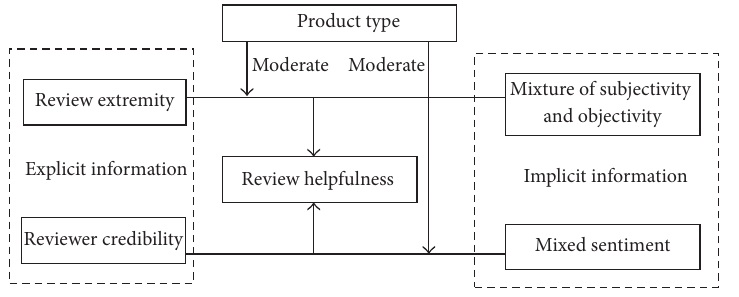
Figure 5: Revised conceptual framework of influencing factors of review helpfulness.